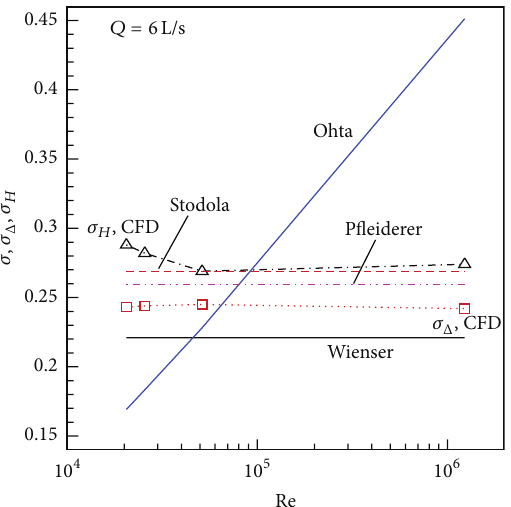
Figure 7: Various slip factors in terms of Reynolds number at